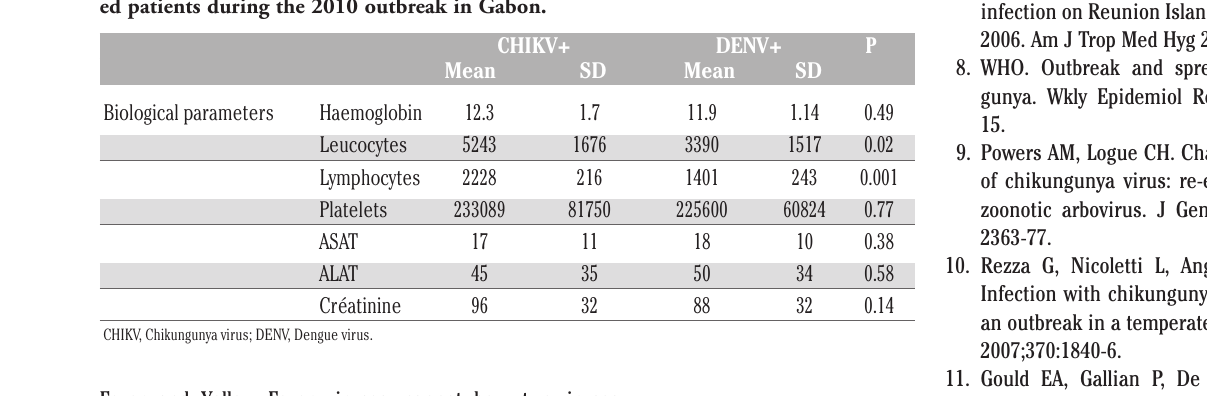
Fever and Yellow Fever viruses, cannot be ruled out.